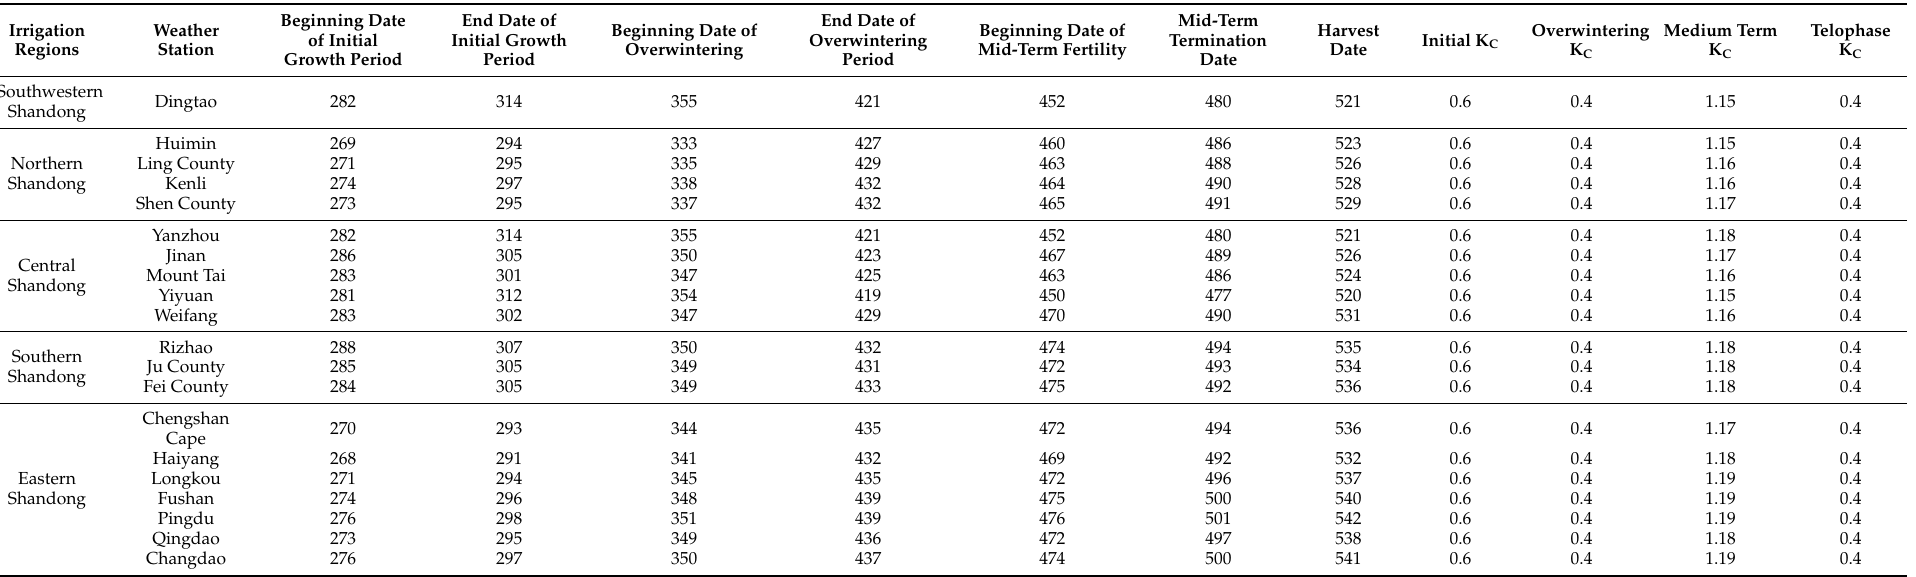
Table A2. Crop coefficients of winter wheat as day of